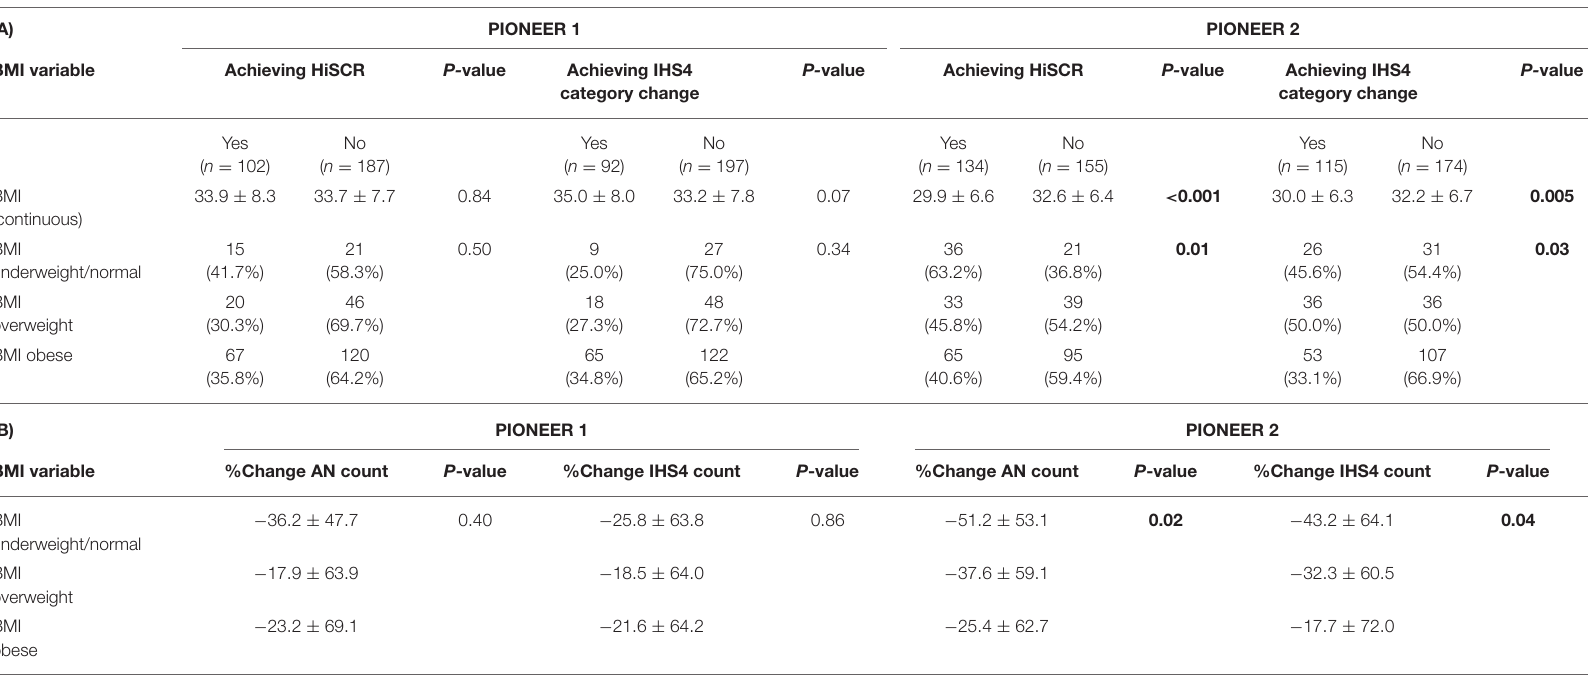
TABLE 2 | (A) Association of BMI with treatment efficacy categorical variables and (B) Association of BMI with treatment efficacy continuous variables (Normal weight is the reference group). (A) PIONEER 1 PIONEER